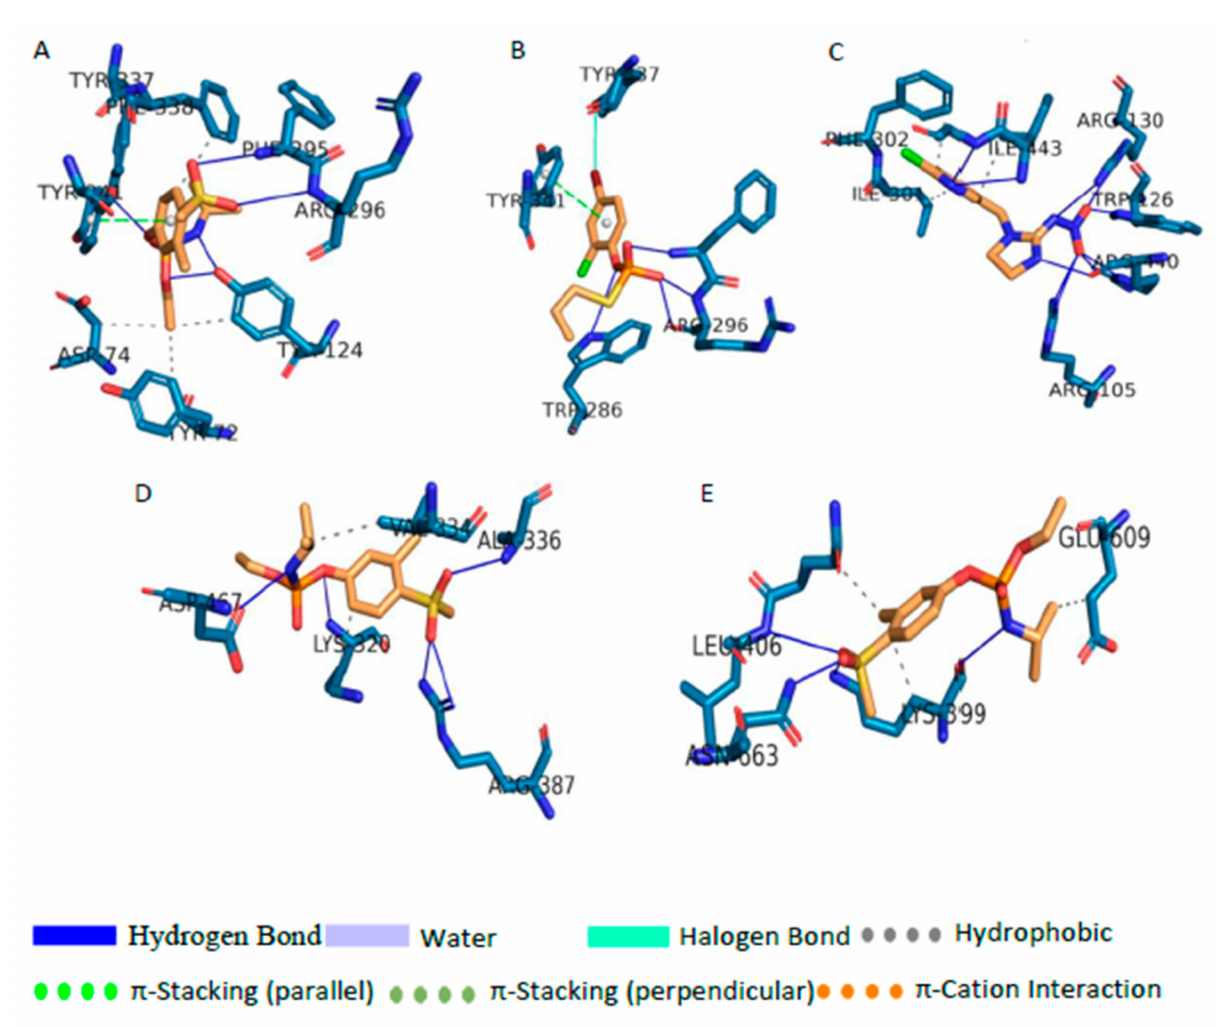
Figure 2. The binding pocket and the non-covalent interactions formed between ( A ) Acetylcholinesterase (AChE) and FMS, ( B ) AChE and M4, ( C ) CP450 and IM, ( D ) Glutaminase (GLS) and FMS, and ( E ) Protein Kinase C (PKC) and